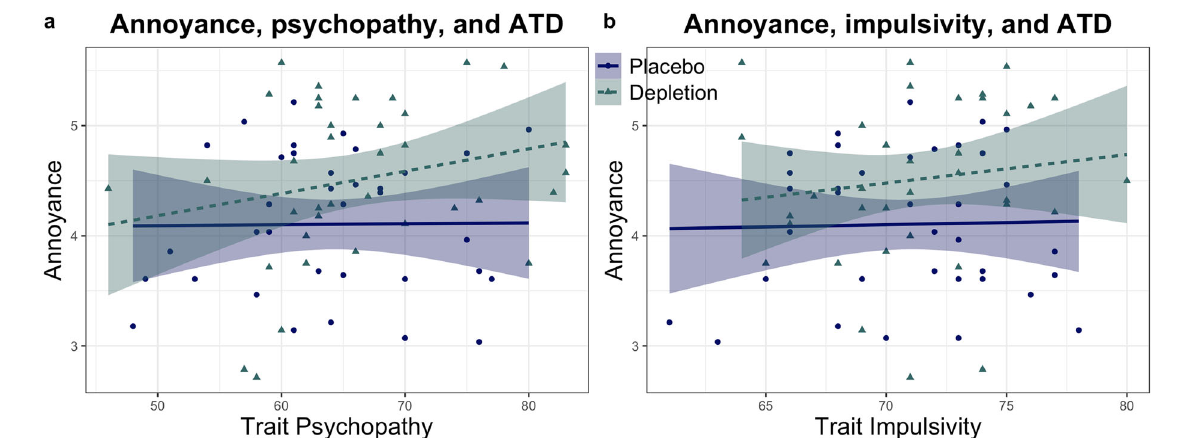
Fig. 3 Effects of trait psychopathy and impulsivity on emotional effects of serotonin depletion. Shading indicates 1 standard error. Each point represents the average emotion ratings for each individual, collapsed across agency and intentionality. a Annoyance was potentiated by serotonin depletion in high-trait psychopathy. b Trait impulsivity did not signi fi cantly enhance the effects of ATD on